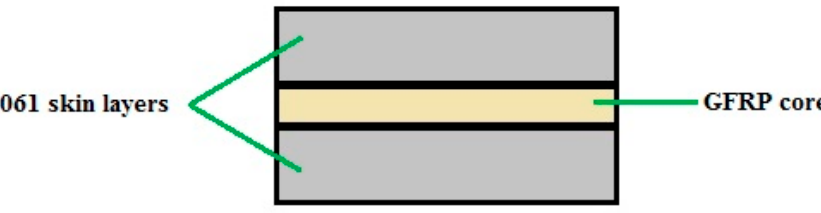
Figure 1. A schematic view of FML with skins and core.